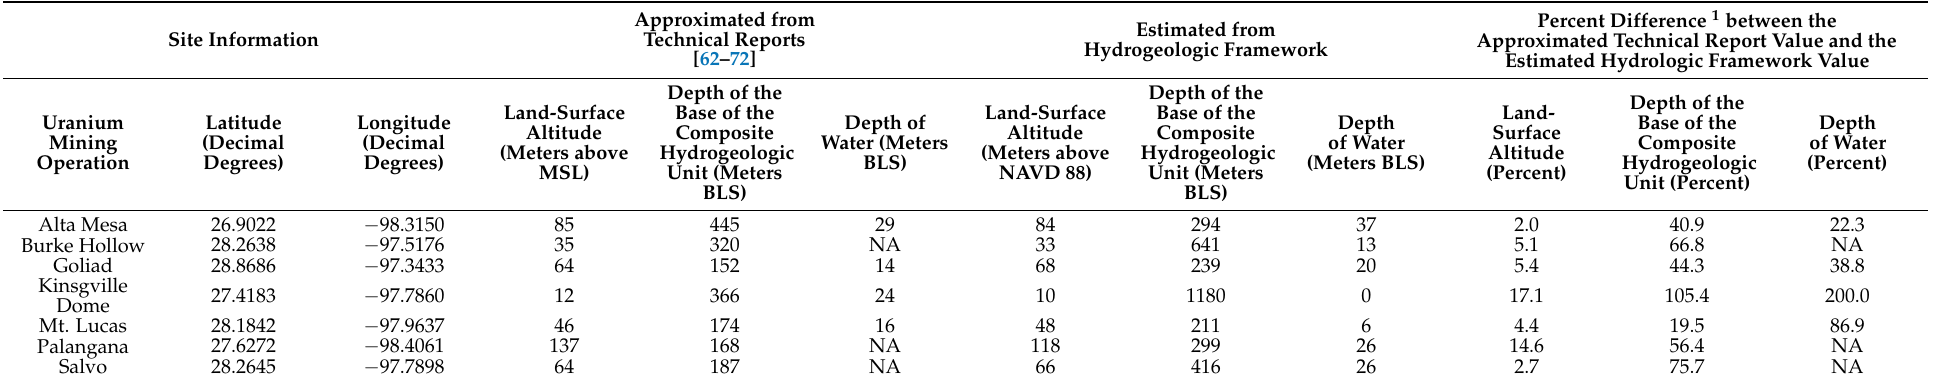
Table 2. Land-surface altitudes, depth of composite hydrogeologic unit, and depth of water approximated from technical reports and estimated from the hydrogeologic framework and the percent difference between the approximated value and the estimated value for uranium mining operations in permissive tract